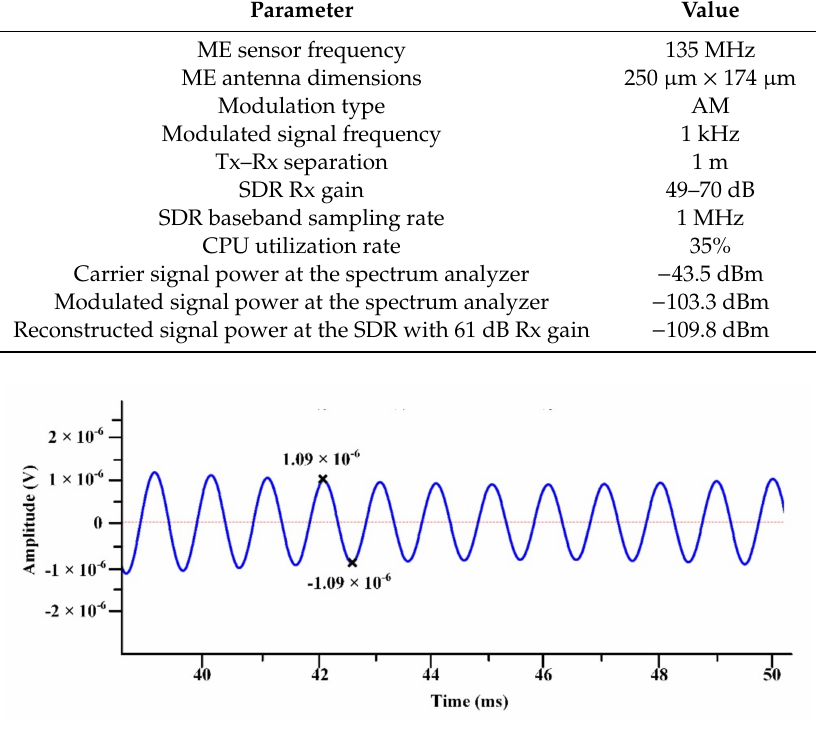
Figure8. Timedomainsignalcapturedfromthe135MHzMEsensor